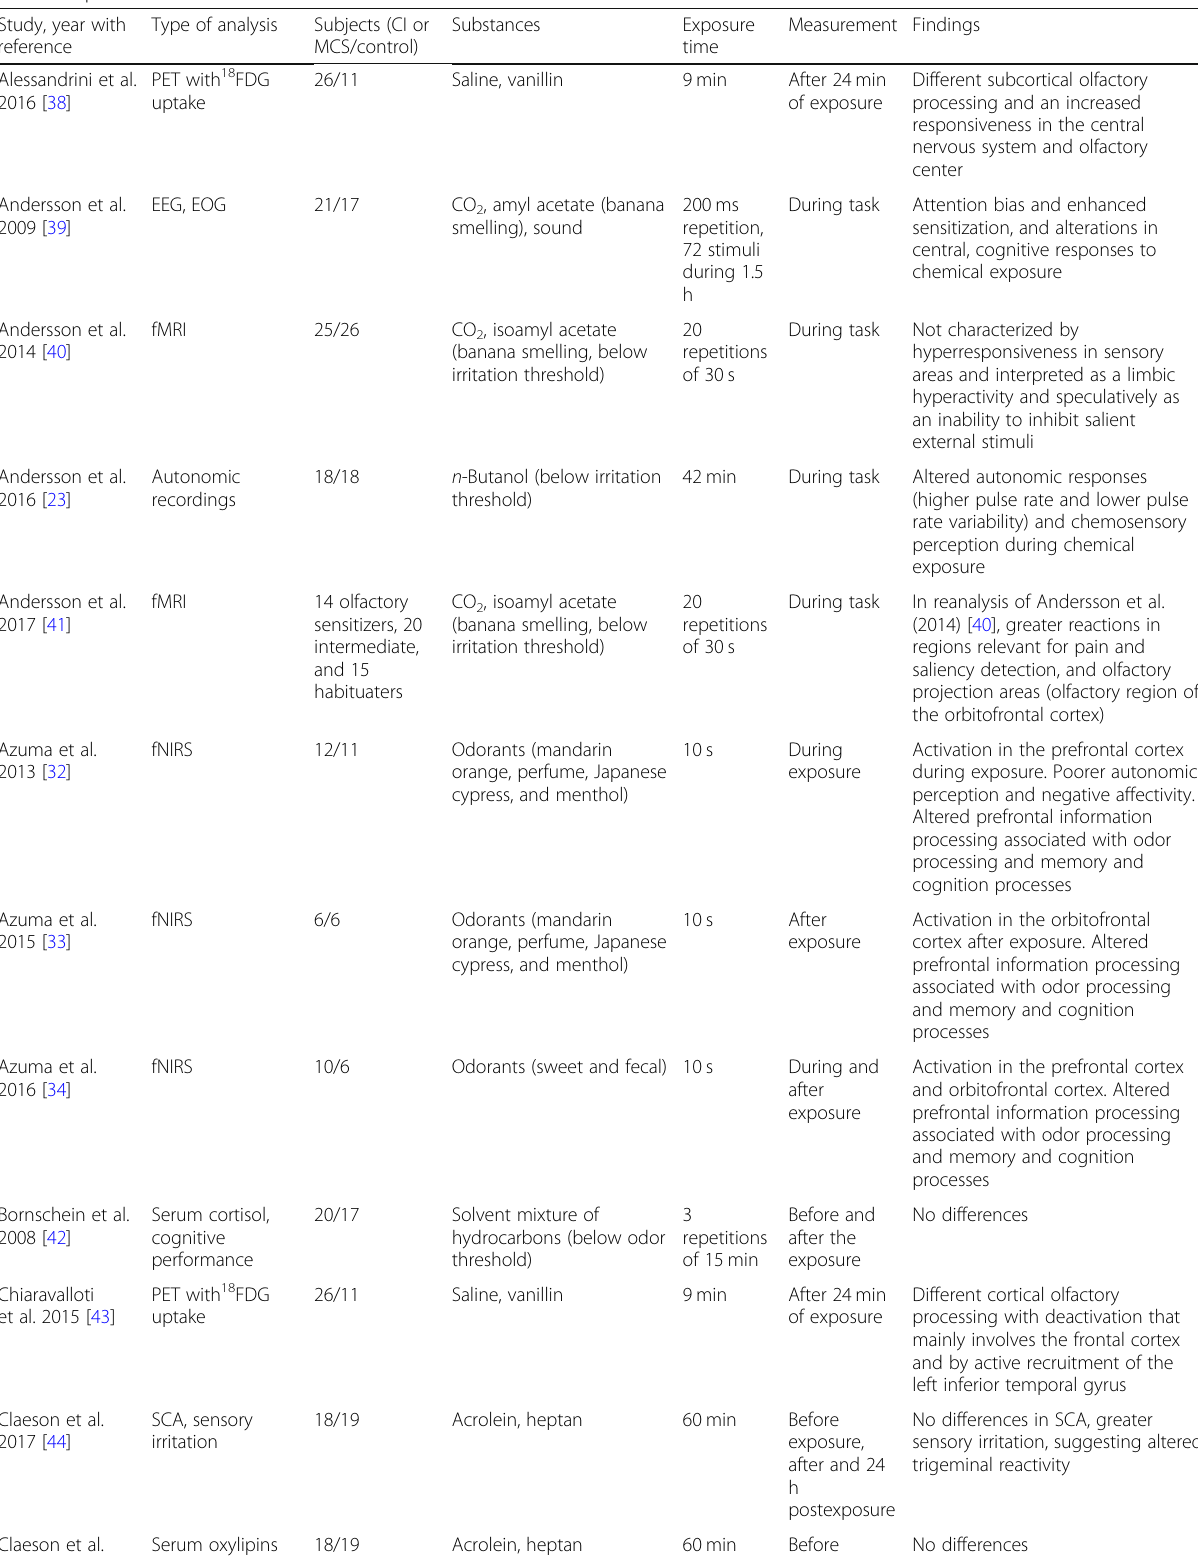
Table 1 Summary of experimental human studies associated with CI and related neurological responses or brain imaging